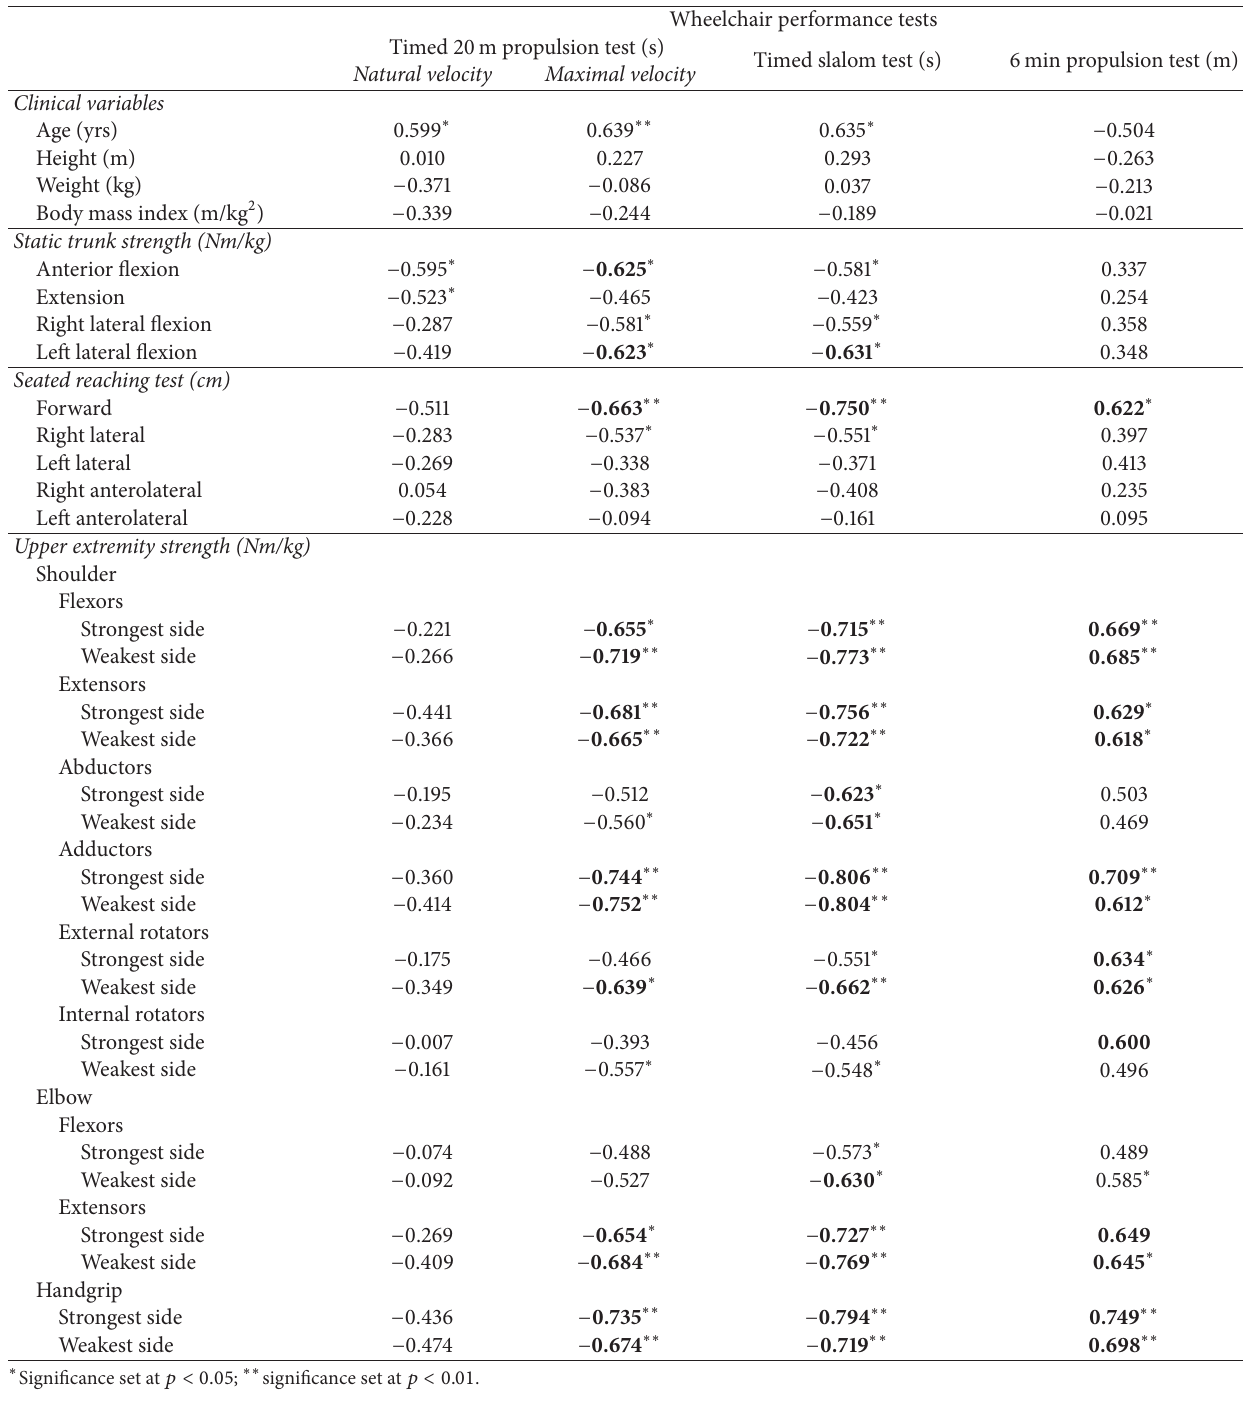
Table 3: Pearson product-moment correlation coefficient ( 𝑟 ) between the clinical, static trunk strength, seated reaching test, and U/E strength outcome measures versus the performance-based timed manual wheelchair tests. For each wheelchair performance test, correlation coefficients highlighted in bold represent the variable entered in its multiple regression analysis (i.e., 𝑟 > 0.6 or 𝑟 < −0.6 ). Note that the proportion of the variance ( 𝑅 2 ) in the wheelchair performance tests that is predictable from each independent variables can be computed by squaring the 𝑟 value ( 𝑟 2 ) reported in the present